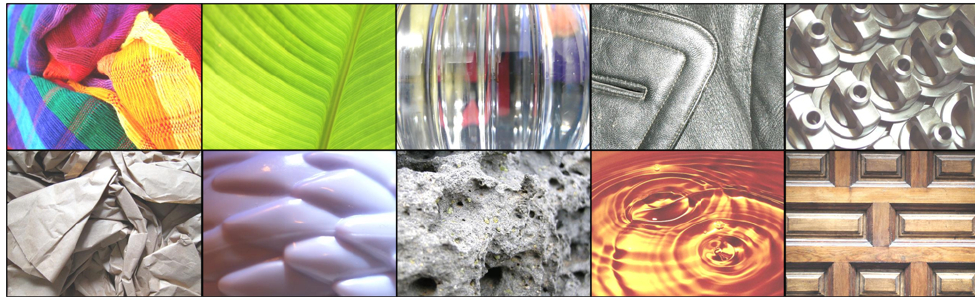
Figure 5. Fixed style images per material selected from the best-scored samples and the widest material regions. From left to right and top to bottom: fabric, foliage, glass, leather, metal, paper, plastic, stone, water, and